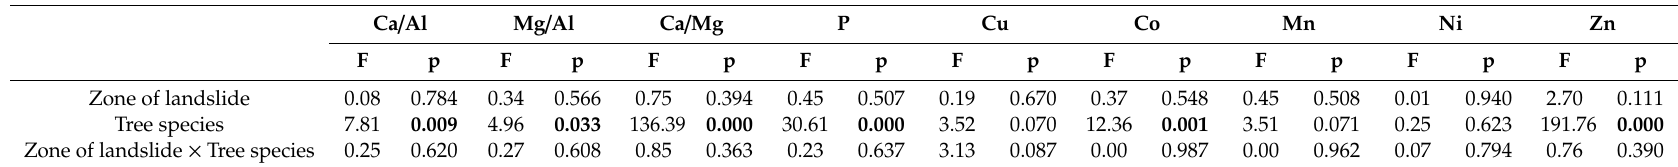
Table 7. Results of general linear model (GLM) analysis for ratio of nutrients and nutrients, including the zone of landslide and tree